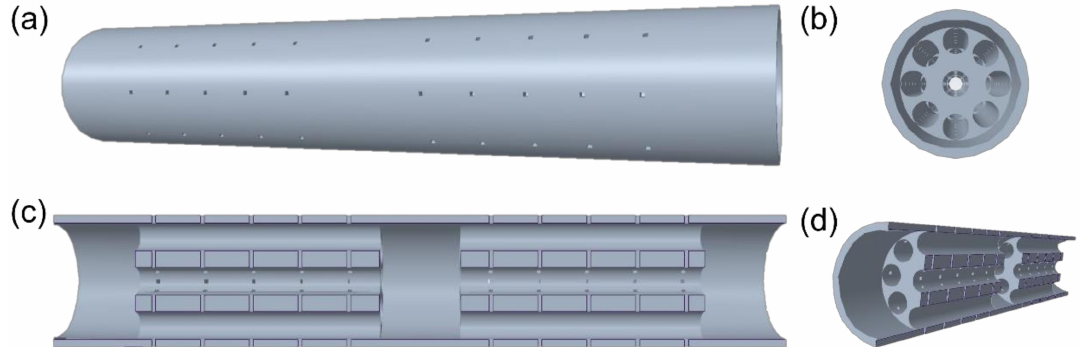
Figure 1. Different views of multichannel NGC: ( a ) standard view; ( b ) side view; ( c ) cross-section view; ( d ) cross-section perspective